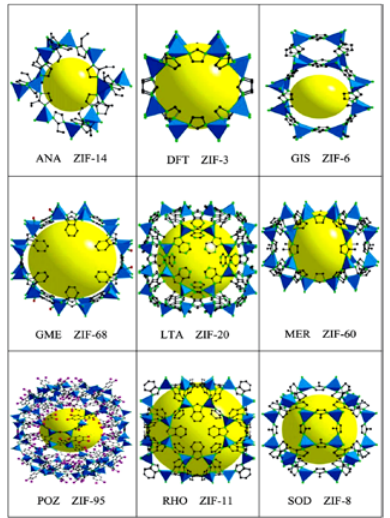
Figure 1. Representative crystal structures of ZIFs (the first three capital letters under each example stand for the zeolite structure code). Reprinted with permission from Reference 6.